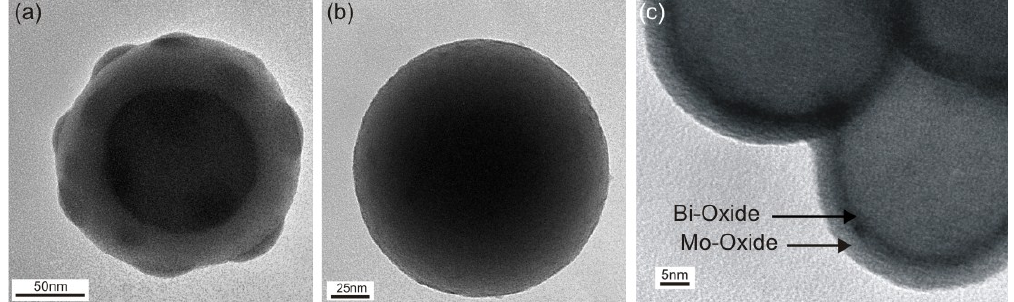
Figure 3. TEM images of ( a ) commercial silica particles (AngstromSphere™) used as-received and coated with molybdenum oxide, where residues on the particle surface hinder conformal coating; ( b ) the same commercial silica particles calcinated prior to coating to remove residues and then coated with molybdenum oxide; ( c ) CVS generated silica particles coated successively with bismuth oxide and molybdenum